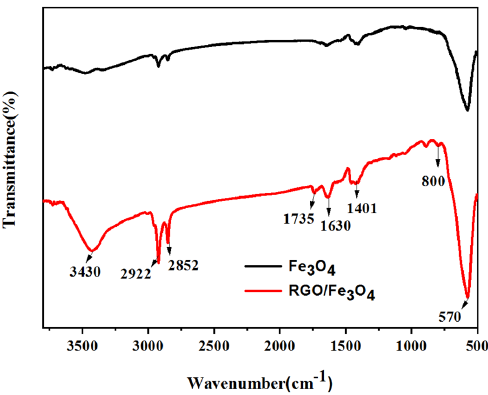
Figure 3. FT − IR spectra of Fe 3 O 4 nanoparticles and RGO/Fe 3 O 4 nanocomposites.